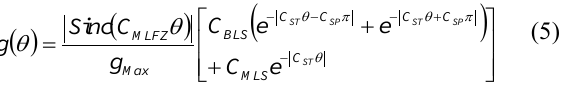
15 Side Lobe Position & Side Lobe Translation